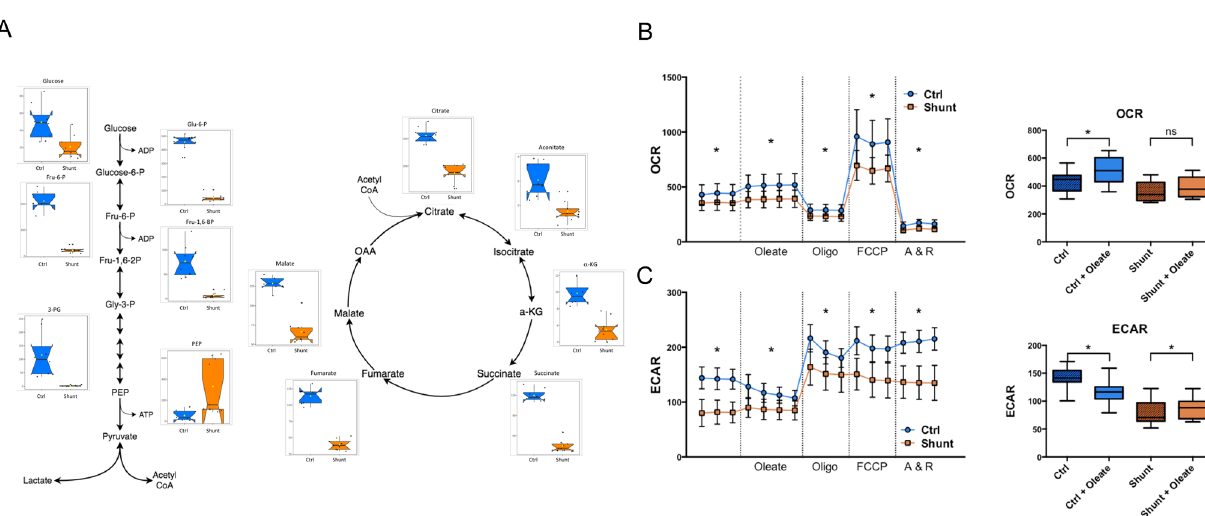
Figure 7. Untargeted metabolomic and extracellular flux analyses demonstrate metabolic abnormalities in shunt LECs. ( A ) Significantly differing metabolites of glycolysis and the TCA cycle in shunt and control LECs by untargeted metabolomic analysis. N = 3 control, 3 shunt. Values expressed as peak intensities with modified vector normalization to the sum of peak heights for all identified metabolites (mTIC) per sample. Data are presented side-by-side as individual data points mapped over notched box and whisker plots with waist at the 50th percentile and edges at the 25th and 75th percentiles respectively. Notch width displays a confidence interval around the median based on the median + / − 1.57 × IQR/sqrt of n. All displayed metabolites exhibit significant differences based on student’s t test with P < 0.05 adjusted for multiple comparisons using a Bonferroni correction. ( B ) Oxygen consumption rate (OCR, pmol O 2 /min/100,000 cells) and ( C ) Extracellular acidification rate (ECAR mpH/min/100,000 cells) comparisons of shunt (orange squares) and control (blue circles) LECs with N = 2 for each of these representative experiments. For each, repeated measurements are shown for the basal condition and following sequential addition of the metabolites and drugs noted on the x-axis, and separated by dotted vertical lines. For each condition, * denotes a significant difference between pooled values for shunt and control LECs with P < 0.05. Also shown is the change in OCR ( B ) and ECAR ( C ) between conditions (basal and following addition of exogenous bioavailable oleic acid) for control and shunt LECs. Pooled values for each condition are presented as box and whisker plots, with * denoting a significant within group difference across conditions with P <